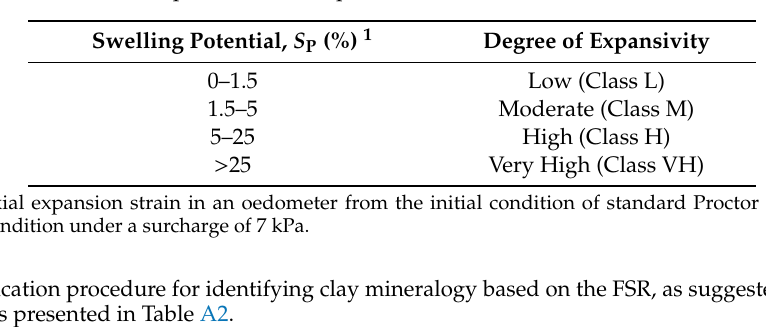
Table A1. Classification procedure for expansive soils based on the oedometer swell test [36].